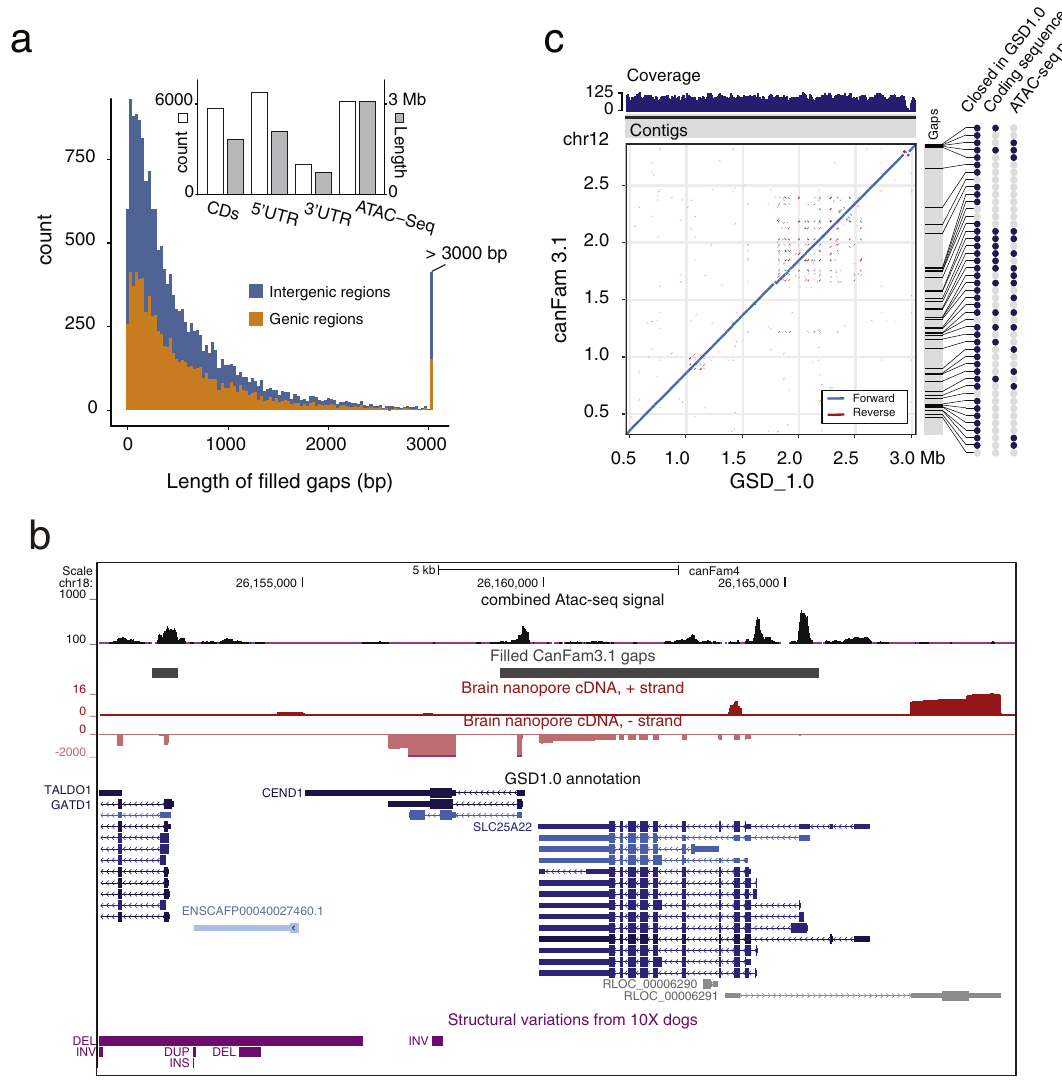
Fig. 2 Filled CanFam3.1 gaps and functionality. a Size distribution and overlap with exons and promoters for the fi lled CanFam3.1 gaps. b Representative GSD_1.0 annotation from the UCSC track hub highlighting available data and an example of a gene hidden in CanFam3.1. c Sequence comparison of DLA on chr 12 between CanFam3.1 and GSD_1.0. The blue indicates a forward alignment and the red indicates a reverse